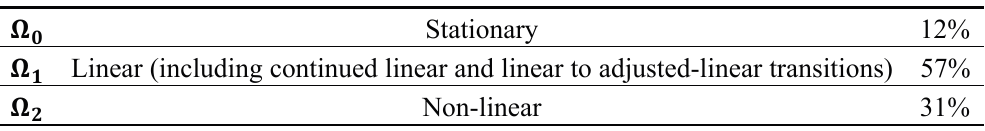
Table 2. States encountered during flight